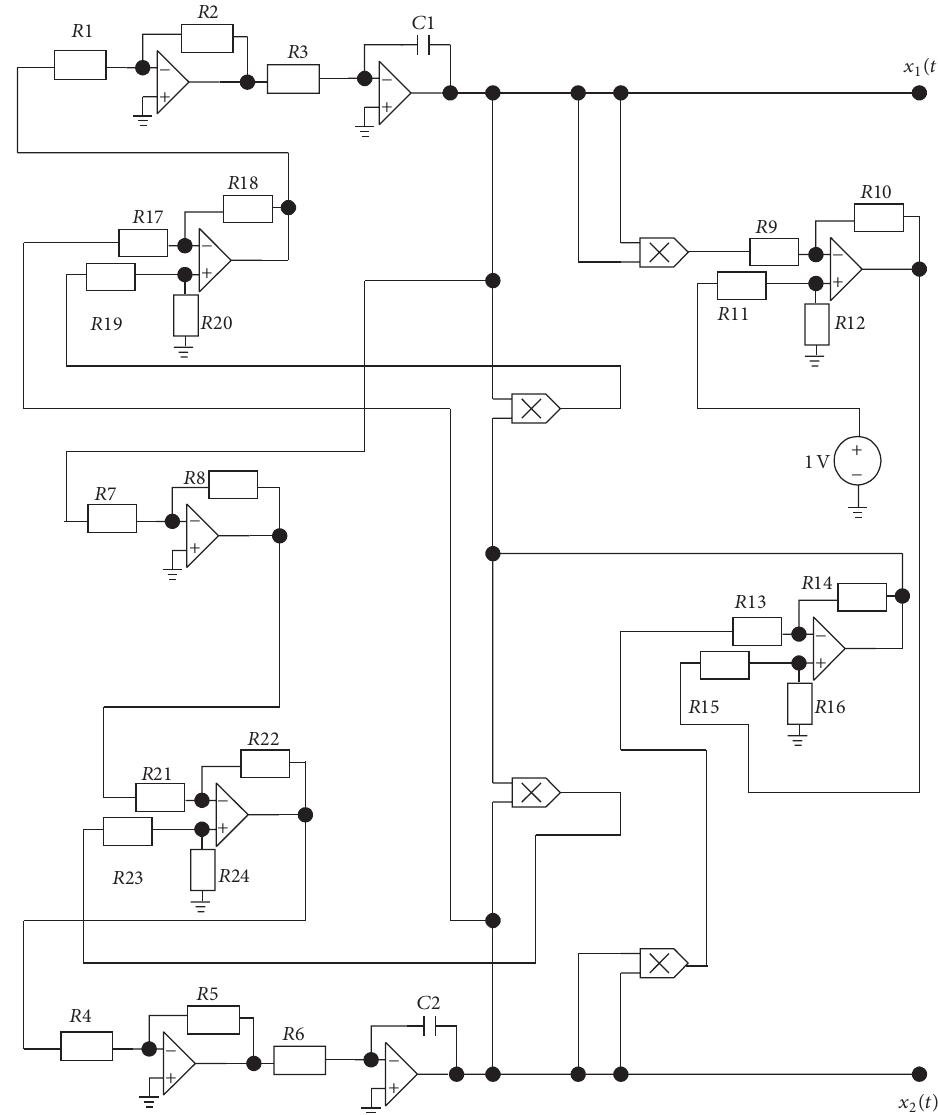
Figure 1: The diagram of implementation, where 𝐶1 = 𝐶2 = 1𝜇 F and 𝑅𝑖 = 100 k Ω, ∀𝑖 ∈ {1, 2,. . .24} .